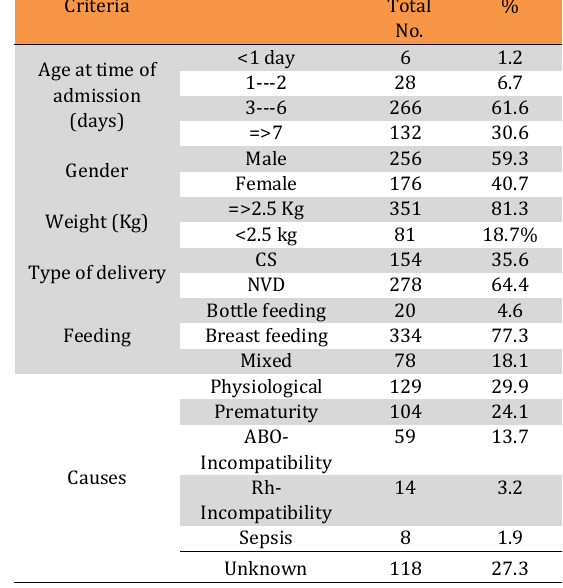
The patients’ criteria.